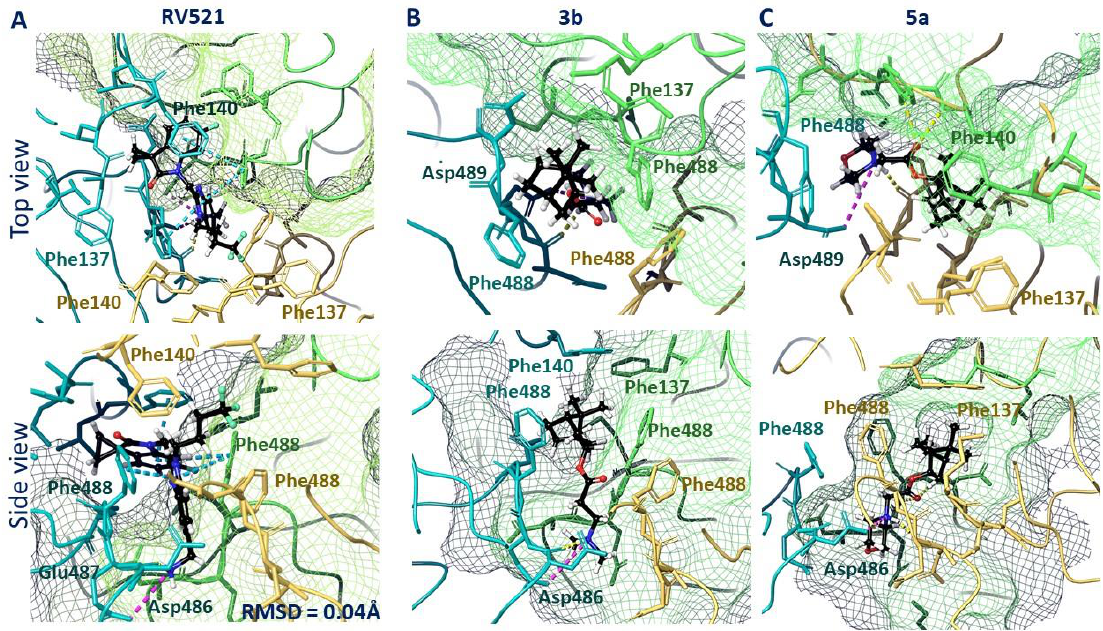
Figure 4. Locations of RV521 reference inhibitor ( A ), compound 3b ( B ), and compound 5a ( C ) in the binding site of F protein: H-bonds and salt bridges are shown as yellow and violet dotted lines, respectively, and pi – pi stacking is presented as blue dotted lines.